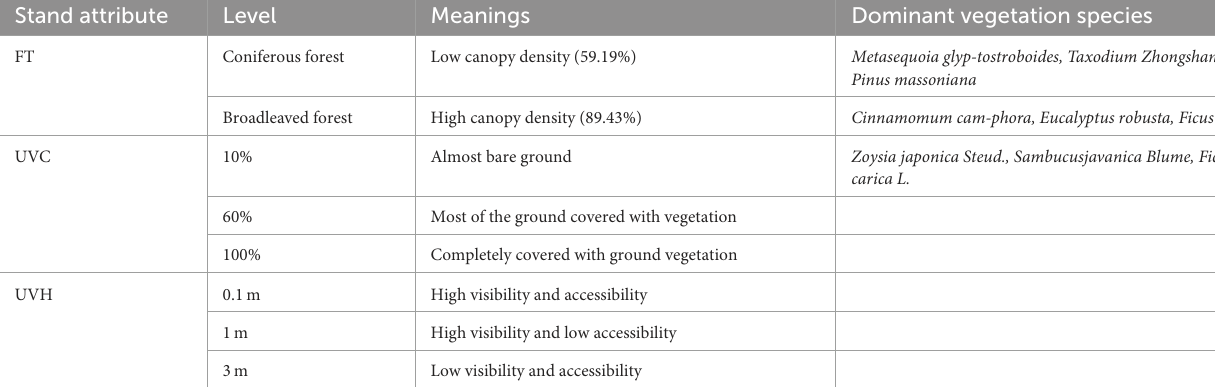
TABLE 1 Virtual reality forest stand attributes and meanings.